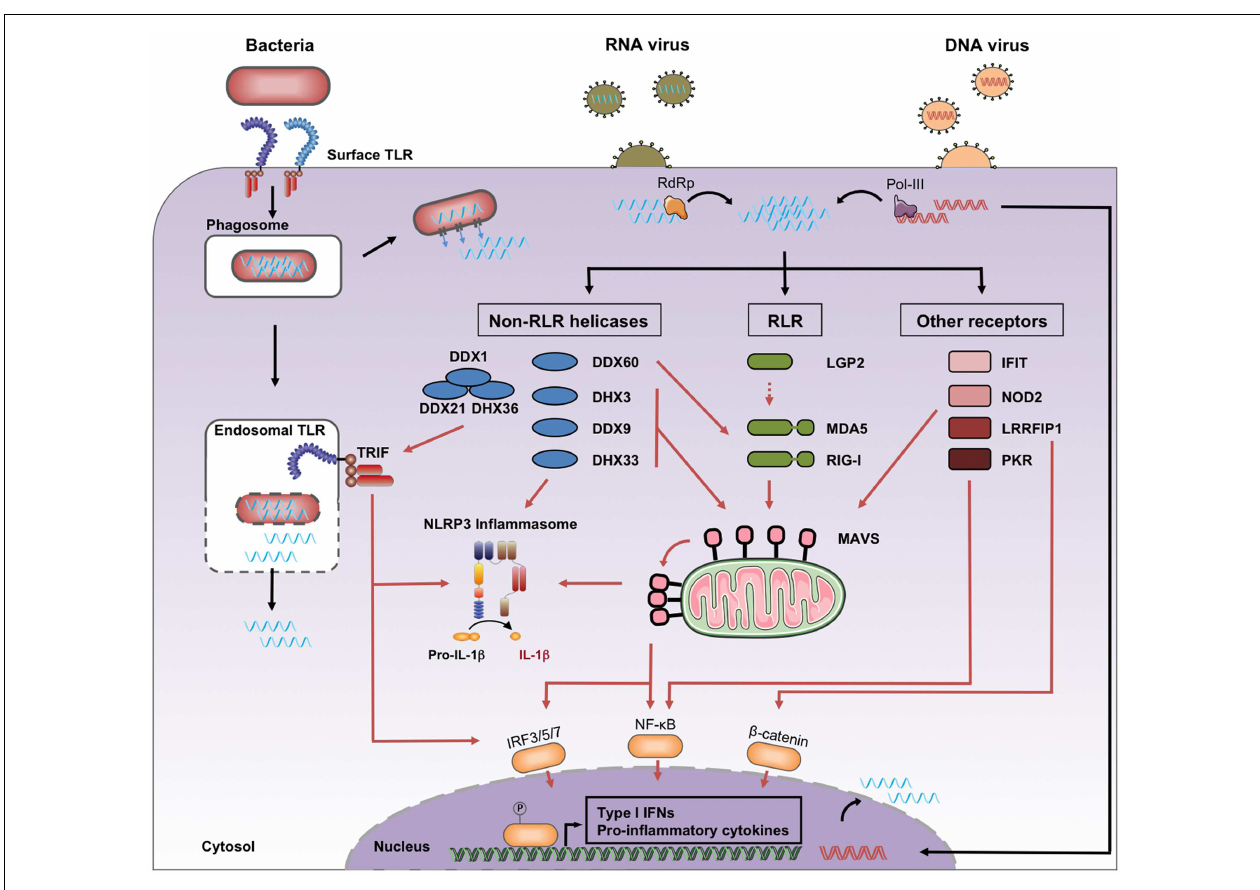
through the activity of auxiliary secretion systems or during passive leakage of phagosomal products. Once in the cytosol, microbial RNA binds different families of PRRs classified as RLRs, non-RLR helicases, and other receptors. Downstream signaling pathways include activation of MAVS,TRIF, and the NLRP3 inflammasome. Black arrows, RNA entry; red arrows, signaling